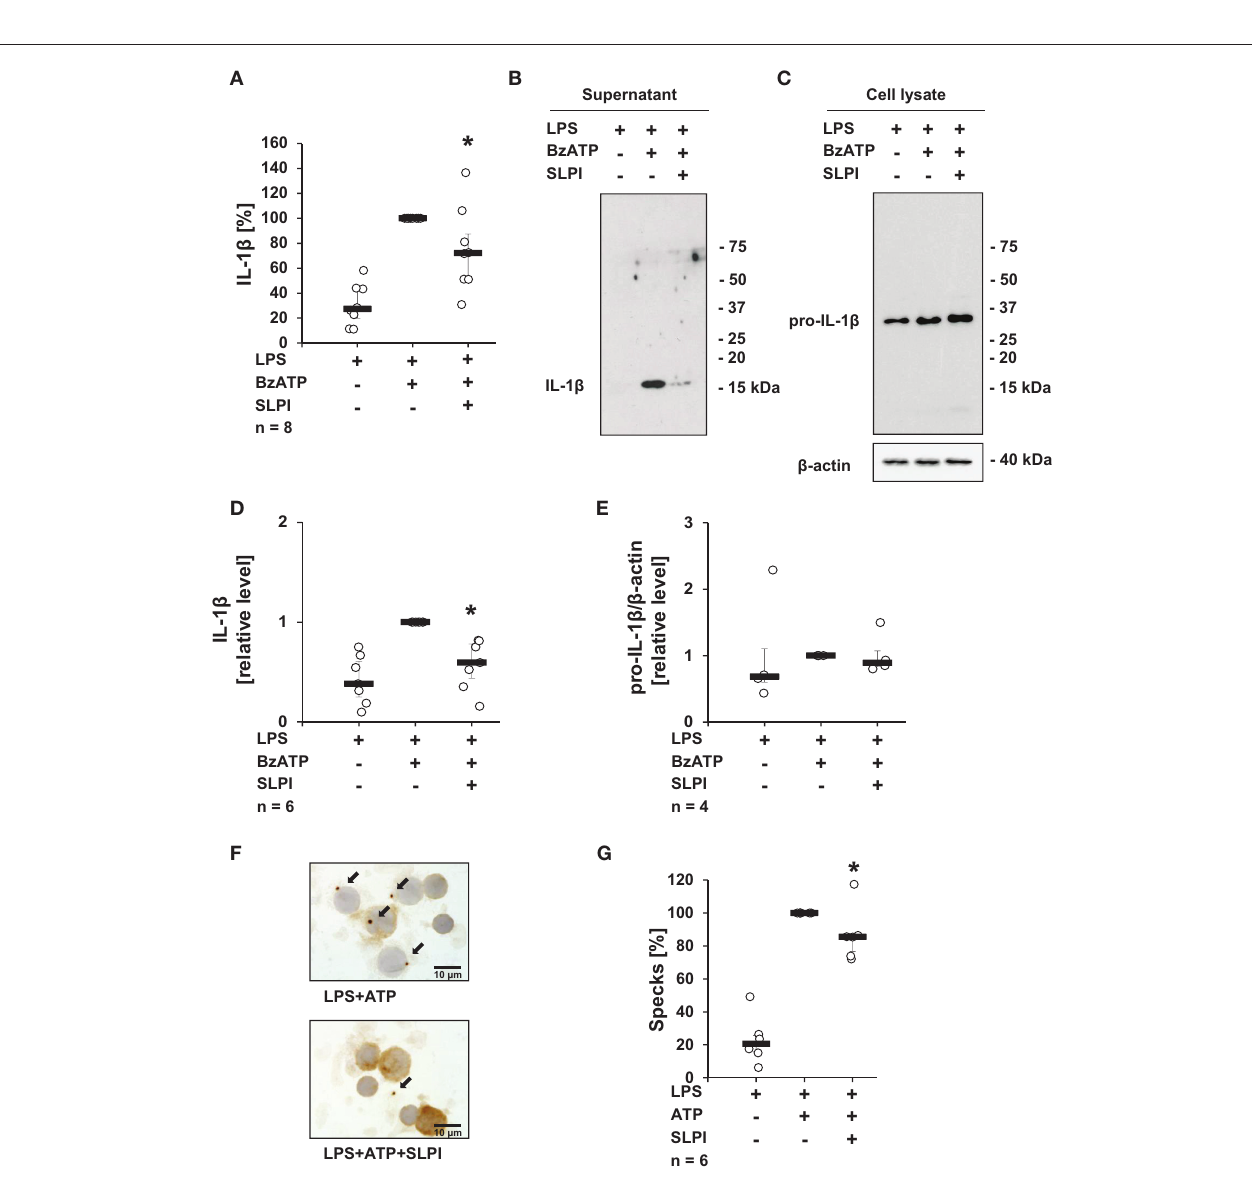
FIGURE 2 | SLPI inhibits the BzATP-induced IL-1 β release by human peripheral blood mononuclear cells (hPBMCs). Blood from healthy volunteers was pulsed with LPS (0.5ng/ml) before isolation of mononuclear cells. Purified hPBMCs were cultured for 3h and stimulated for 30min with 2 ′ (3 ′ )-O-(4-benzoylbenzoyl)adenosine 5 ′ -triphosphate triethylammonium salt (BzATP, 100 µ M) in the presence or absence of SLPI (10 µ g/ml). The concentration of IL-1 β in cell culture supernatants was measured by ELISA or assessed by immunoblotting. (A) SLPI inhibited the BzATP-mediated IL-1 β release. The amount of IL-1 β released upon stimulation with BzATP was set to 100% and the remaining values were calculated accordingly. * p ≤ 0.05 significantly different compared to cells stimulated with LPS and BzATP. Experimental groups were compared by Wilcoxon signed-rank test. (B) The level of IL-1 β detected in cell culture supernatants was diminished upon treatment with SLPI; one representative immunoblot out of 6 is shown. (C) Equal levels of pro-IL-1 β were detected by immunoblotting in cell lysates obtained from hPBMCs independent of the treatment. Detection of β -actin served as a loading control. One representative blot out of 4 is shown. (D) Optical density of the immune-positive bands was measured. The values obtained after LPS and BzATP stimulation were set to one and the rest of the values were calculated accordingly. (E) Optical density of the immune-positive bands for pro-IL-1 β was measured and divided by the values obtained for β -actin on the same blot. The values obtained after LPS and BzATP stimulation were set to one, all other values were calculated accordingly. * p ≤ 0.05 significantly different compared to cells stimulated with LPS and BzATP (D,E) . Experimental groups were compared by Kruskal-Wallis test followed by Mann-Whitney rank sum test. (F) ASC (apoptosis-associated speck-like protein containing a caspase activation and recruitment domain) specks (arrows) were detected by immunocytochemistry using antibodies directed to ASC (brown staining). Cell nuclei were delicately counterstained with hemalum. Representative specimens out of 6 individual experiments each are shown. (G) Specks were induced by the treatment with ATP (1mM) and significantly reduced, when SLPI was given concomitantly. The number of specks per 100 cells obtained after stimulation with ATP was set to 100% and the remaining values were calculated accordingly. * p ≤ 0.05 significantly different compared to cells pulsed with LPS and stimulated with ATP (G) . Experimental groups were compared by Wilcoxon signed-rank